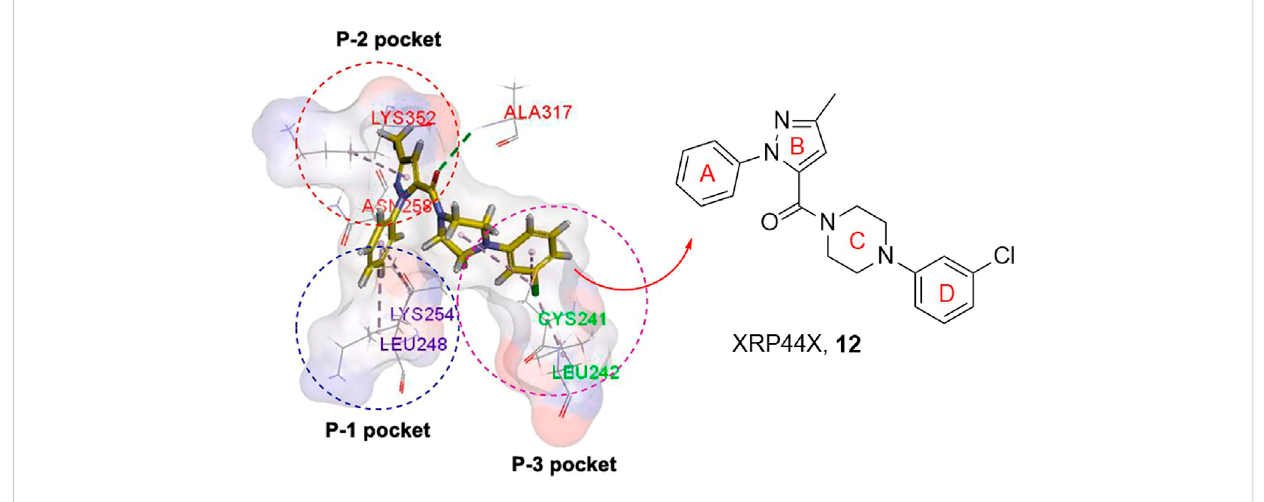
FIGURE 2 The binding mode of XRP44X against